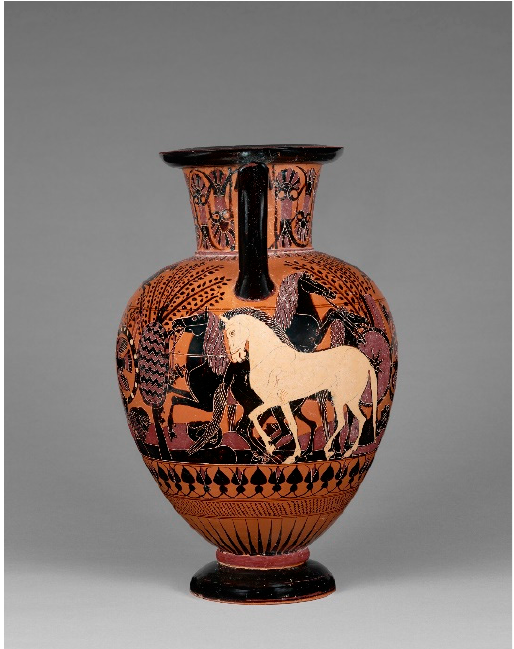
Figure 16. Chalcidian Neck Amphora. Attributed to the Inscription Painter. Ca. 570-530 BCE. Getty Museum. Inv. no. 96.AE.1. Digital Image Courtesy of the Getty’s Open Content Program.